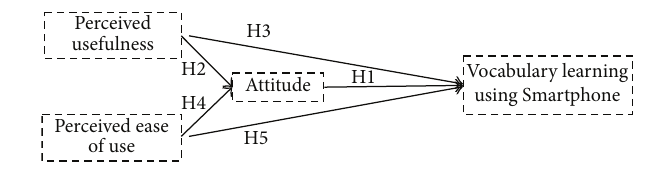
Figure 1: Research